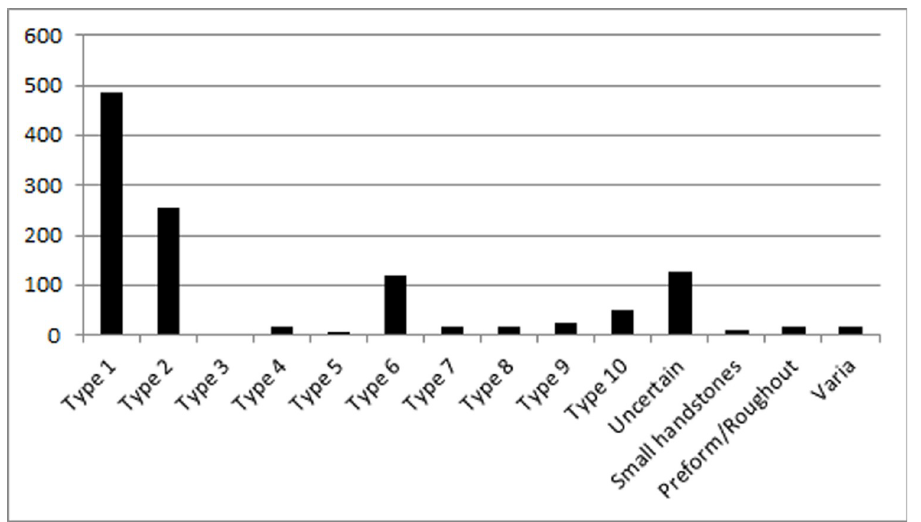
Fig 9. Distribution of the types of handstones at Go¨bekli Tepe. The statistical analysis is based on 1166 finds, which were analyzed in terms of both formal and functional aspects (graph L. Dietrich; the graph does not include preforms).